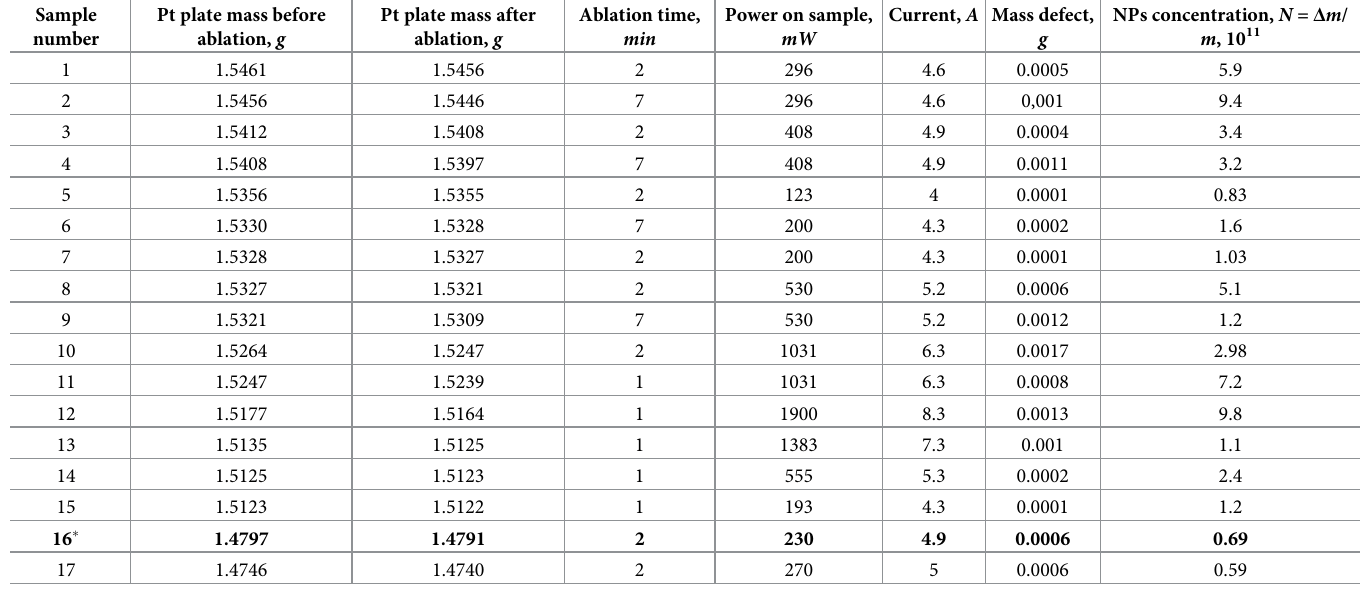
Table 1. Pt NPs ablation parameters.